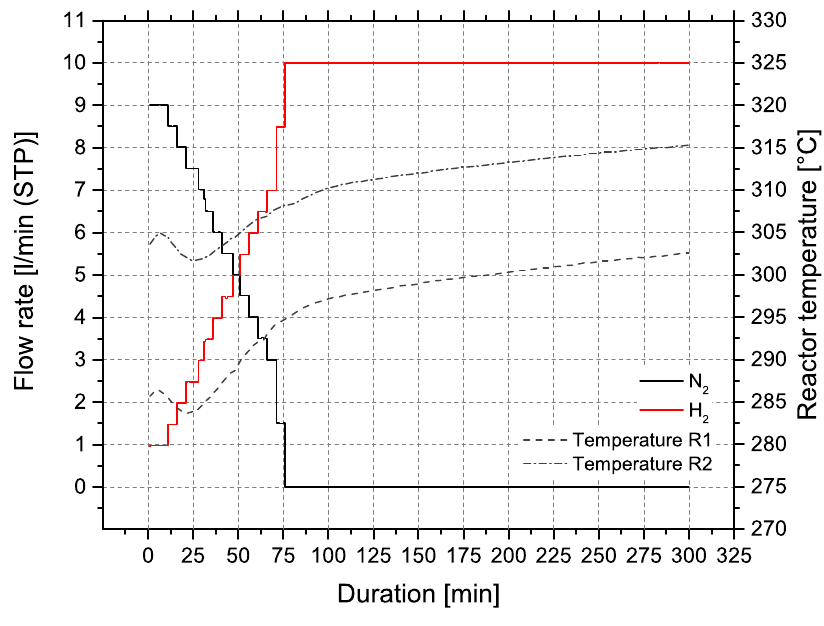
Figure 7. Activation process of honeycomb catalysts in reactors R1 and R2, p = 1–2